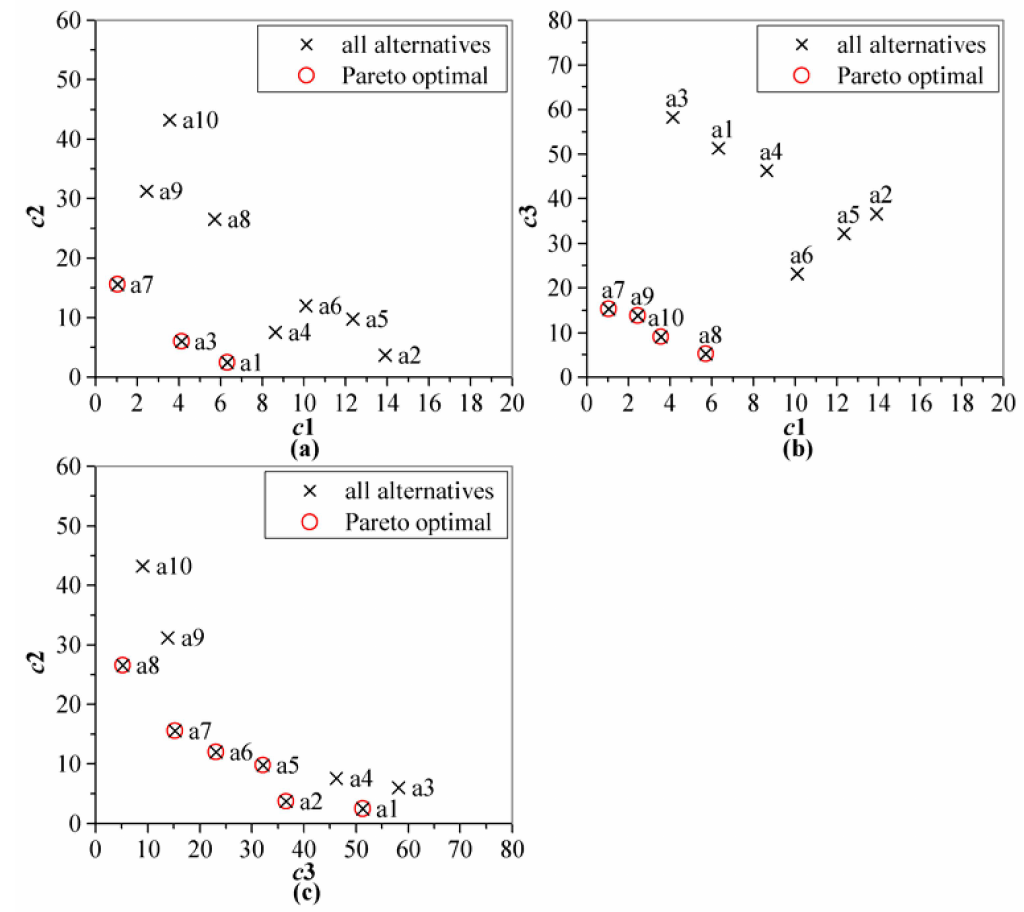
Figure 4. Two-dimensional Pareto plots of the three criteria: ( a ) c 1 versus c 2; ( b ) c 1 versus c 3; ( c ) c 3 versus c